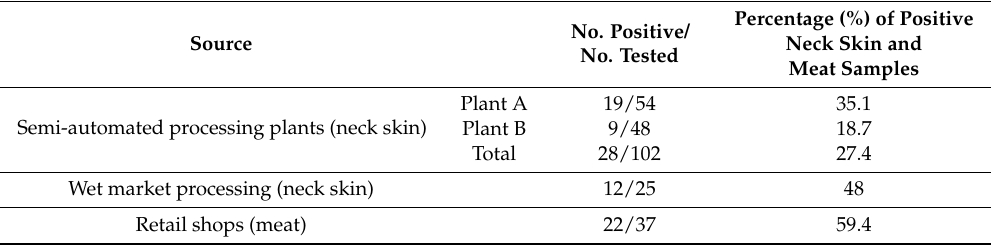
Table 1. Prevalence of Campylobacter from different sources.